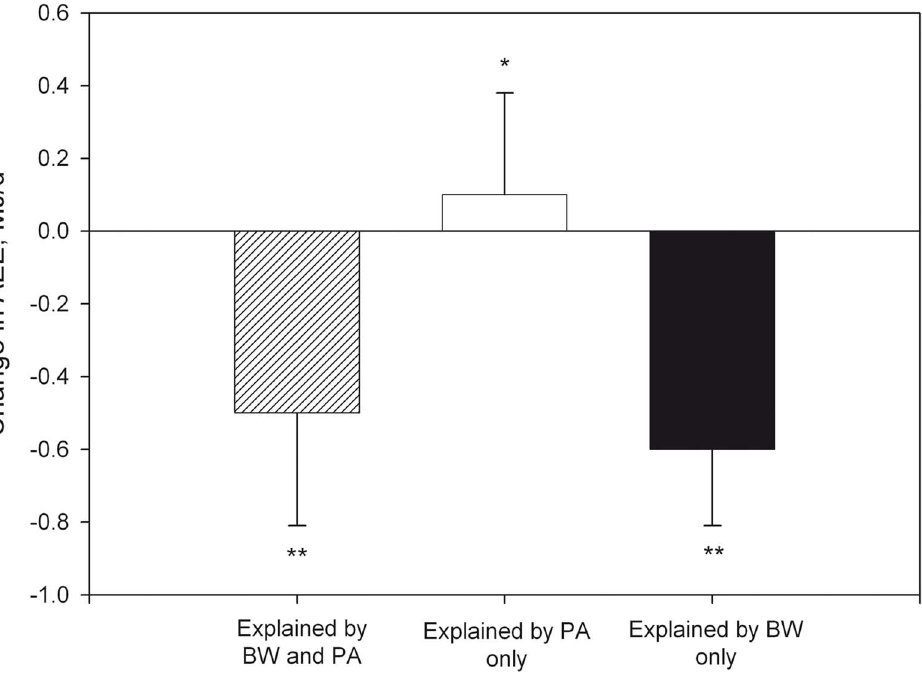
Figure 4. Contribution of the change in body weight (BW) and the change in physical activity (PA) to the change in activity energy expenditure (AEE). (*) or (**); significant difference from zero (P , 0.05 or P ,